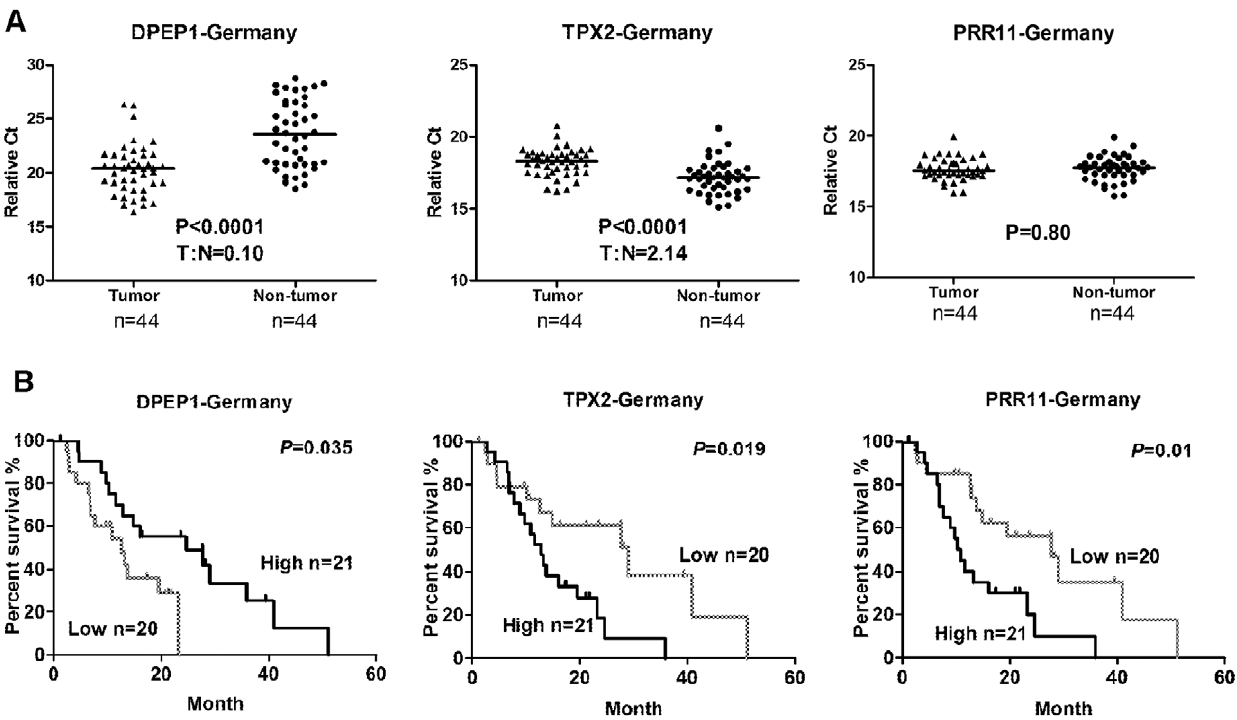
Figure 1. DPEP1, TPX2 and PRR11 expression are associated with cancer-specific death in test Germany cohort. A: DPEP1 was expressed at a lower level and TPX2 at a higher level in pancreatic tumors as compared to adjacent non-tumor tissue. Dot plots represent gene expression level with relative threshold cycle value (Ct) normalized with endogenous control gene GAPDH. Bars indicate median value. Wilcoxon matched-pairs t-tests P value and tumor: non-tumor ratios (T:N) are indicated in the graphs. B: Kaplan Meier analysis of DPEP1, TPX2, and PRR11 in the Germany test cohort.